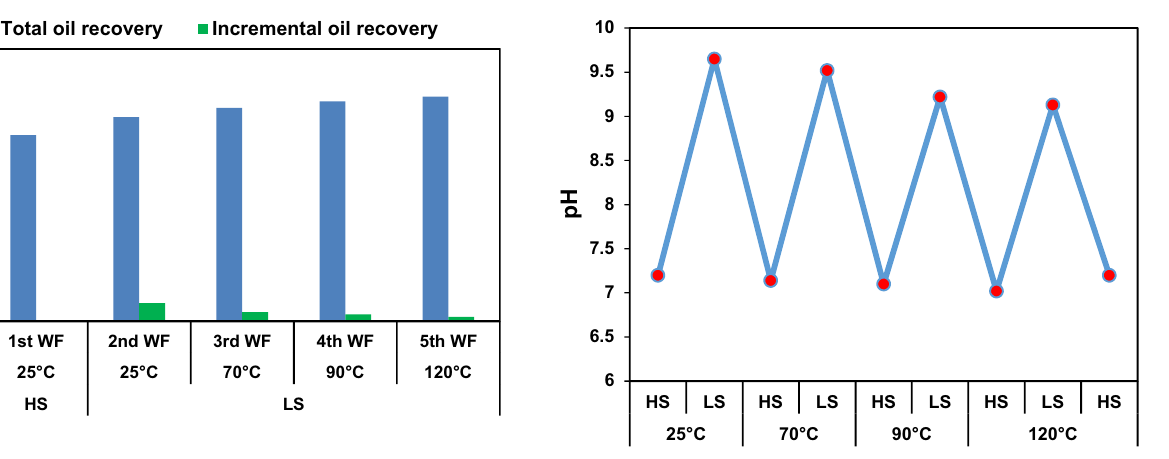
Fig. 6 Effluent pH from sand column#1 (sand + illite), at 25, 70,